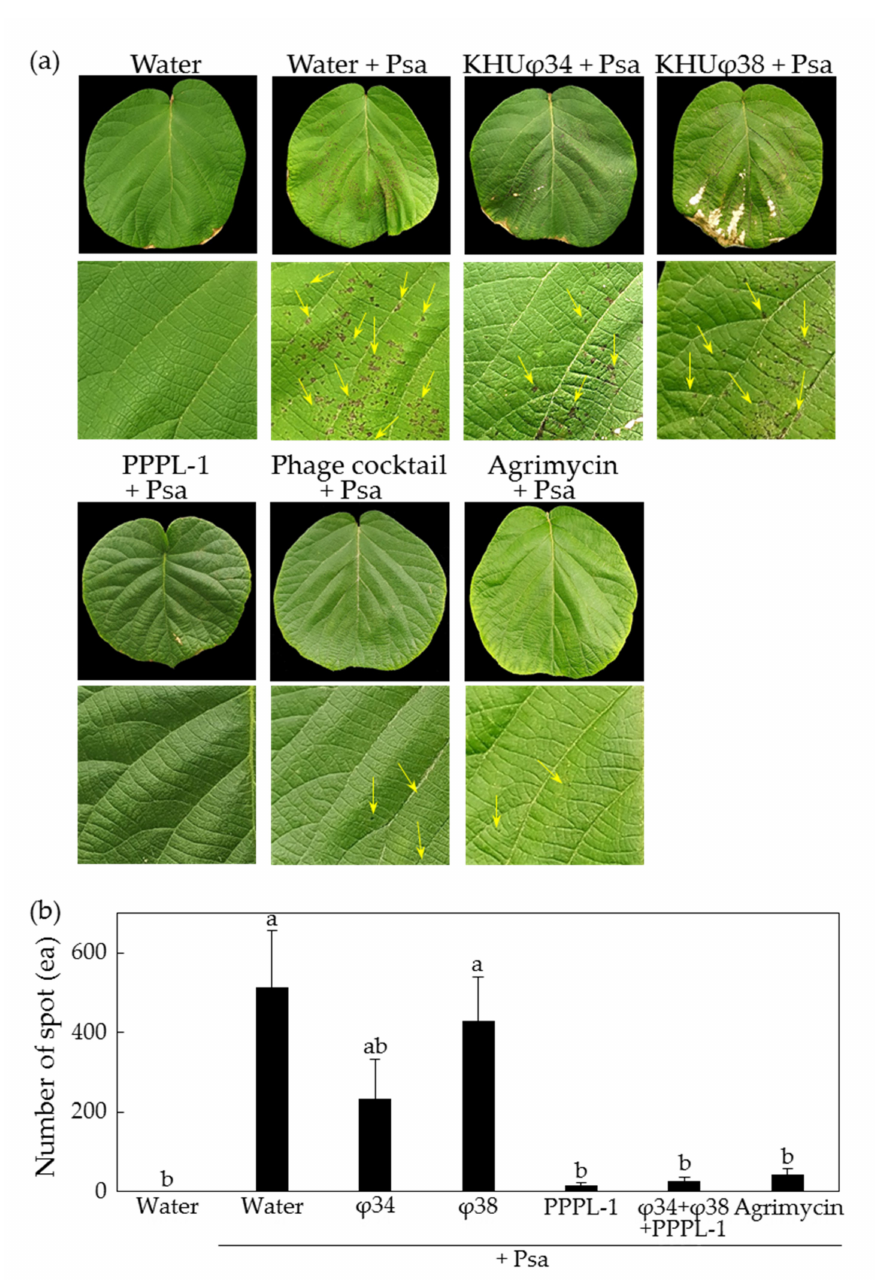
Figure 2. Control efficacy of PPPL-1 phage compared to KHU ϕ 34, KHU ϕ 38, or phage cocktail with all three phages against bacterial canker caused by Pseudomonas syringae pv. actinidiae (Psa) KBE9 and SYS1 mixture in planta. ( a ) The kiwifruit leaves 10 days after Psa inoculation (dai) with phages or antibiotic pesticide. Bottom figures of each treatment are enlarged photographs of top leaves. The yellow arrows indicate symptomatic spots. The sterilized water was used for dilution of phages and bacteria. Buffer, each phage (10 8 pfu/mL), or Agrimycin™ (0.4 g/L) was treated 2 h before treatment with bacterial suspension (10 8 cfu/mL). Mock and buffer are sterilized water. ( b ) The mean of number of symptomatic spots on the treated leaves ( n = 12). The error bars indicate the standard error, and the different letters on top of each bar indicate the different groups based on significant differences at p < 0.05 by Duncan’s multiple range test at 10